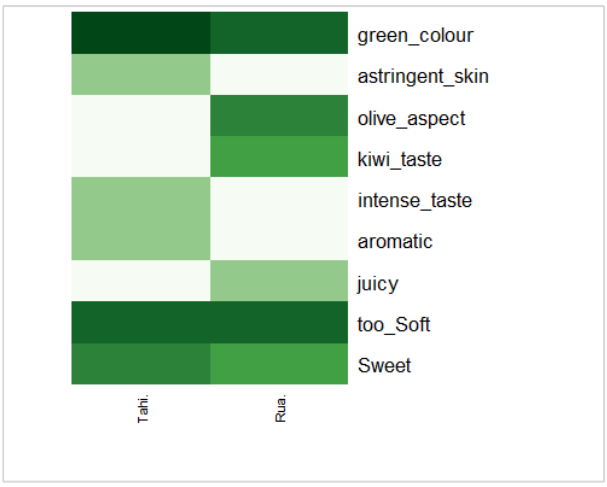
Figure 2. Heatmap 2 of the p -values of sensorial responses.